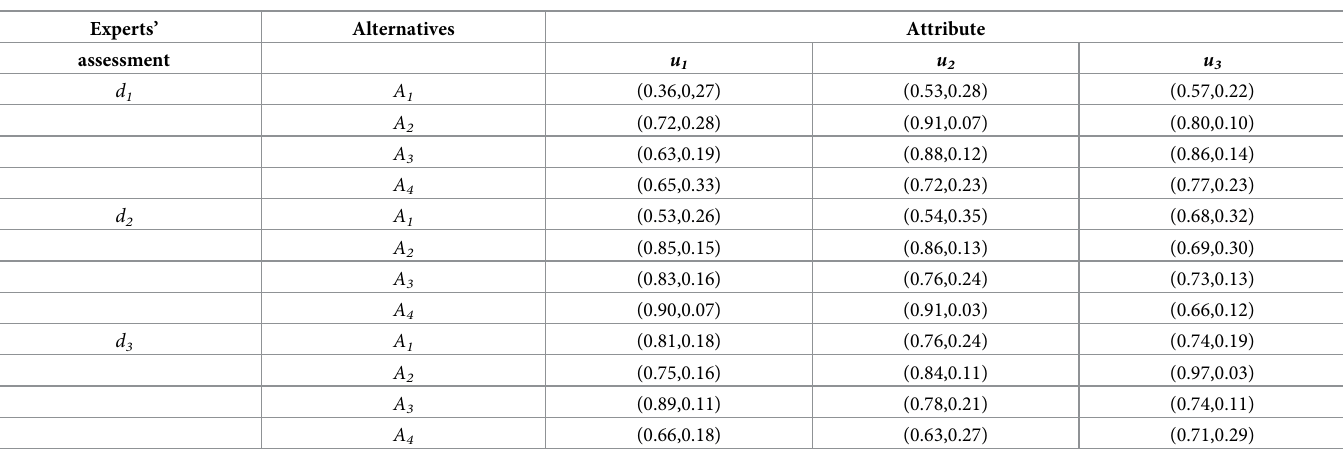
Table 2. Three score attribute matrices.